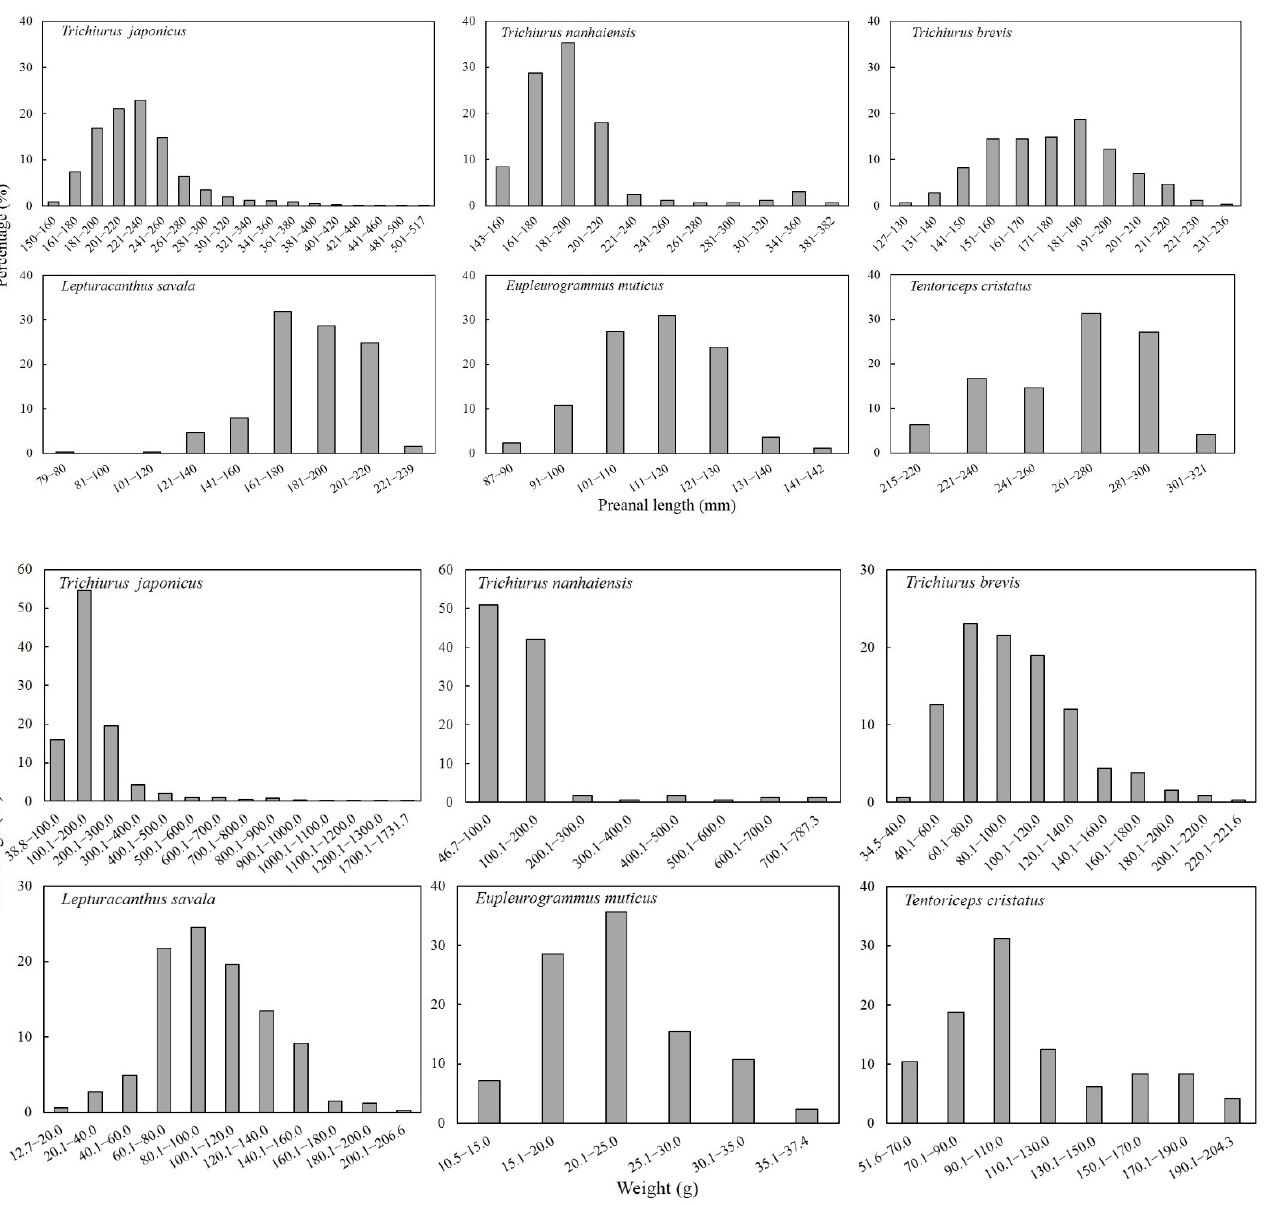
Figure 2. Population composition in terms of preanal length and body weight of six species of Trichiuridae in Chinese seas.